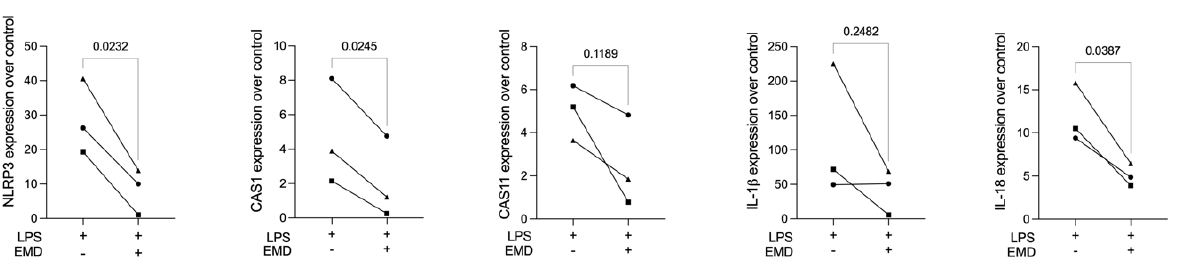
Figure 2. LPS stimulation caused an increase in the expression of the pyroptosis genes in primary macrophages. The application of EMD prior to LPS stimulation in primary macrophages led to a reduction in the forced expression of NLRP3, CAS1, and IL-18, and a trend in the reduction of CAS11 and IL-1 β in primary macrophages. Different symbol shapes mean independent experiments. Paired t -test statistical analysis was applied to compare the groups.